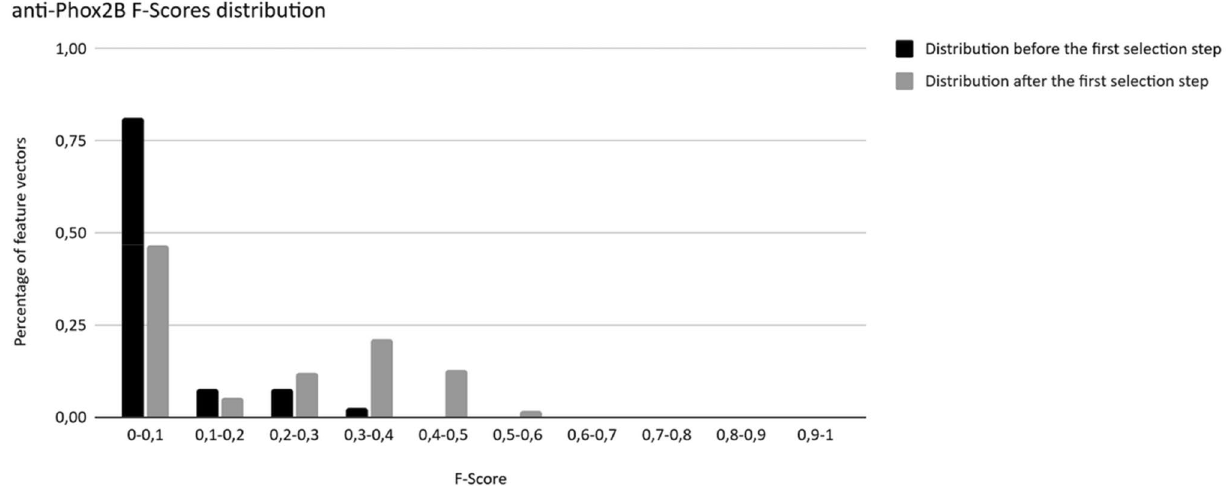
Figure 9. Evolution of the F-Score distribution among all combinations evaluated before and after the first selection step for anti-Phox2B dataset.